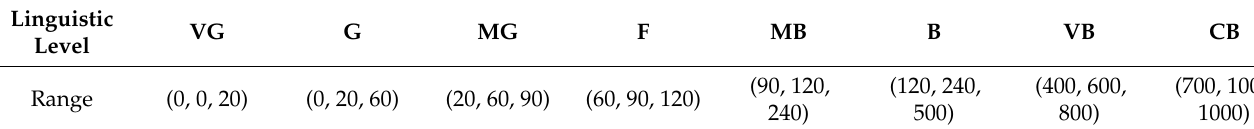
Table 3. TPN values of output variables.